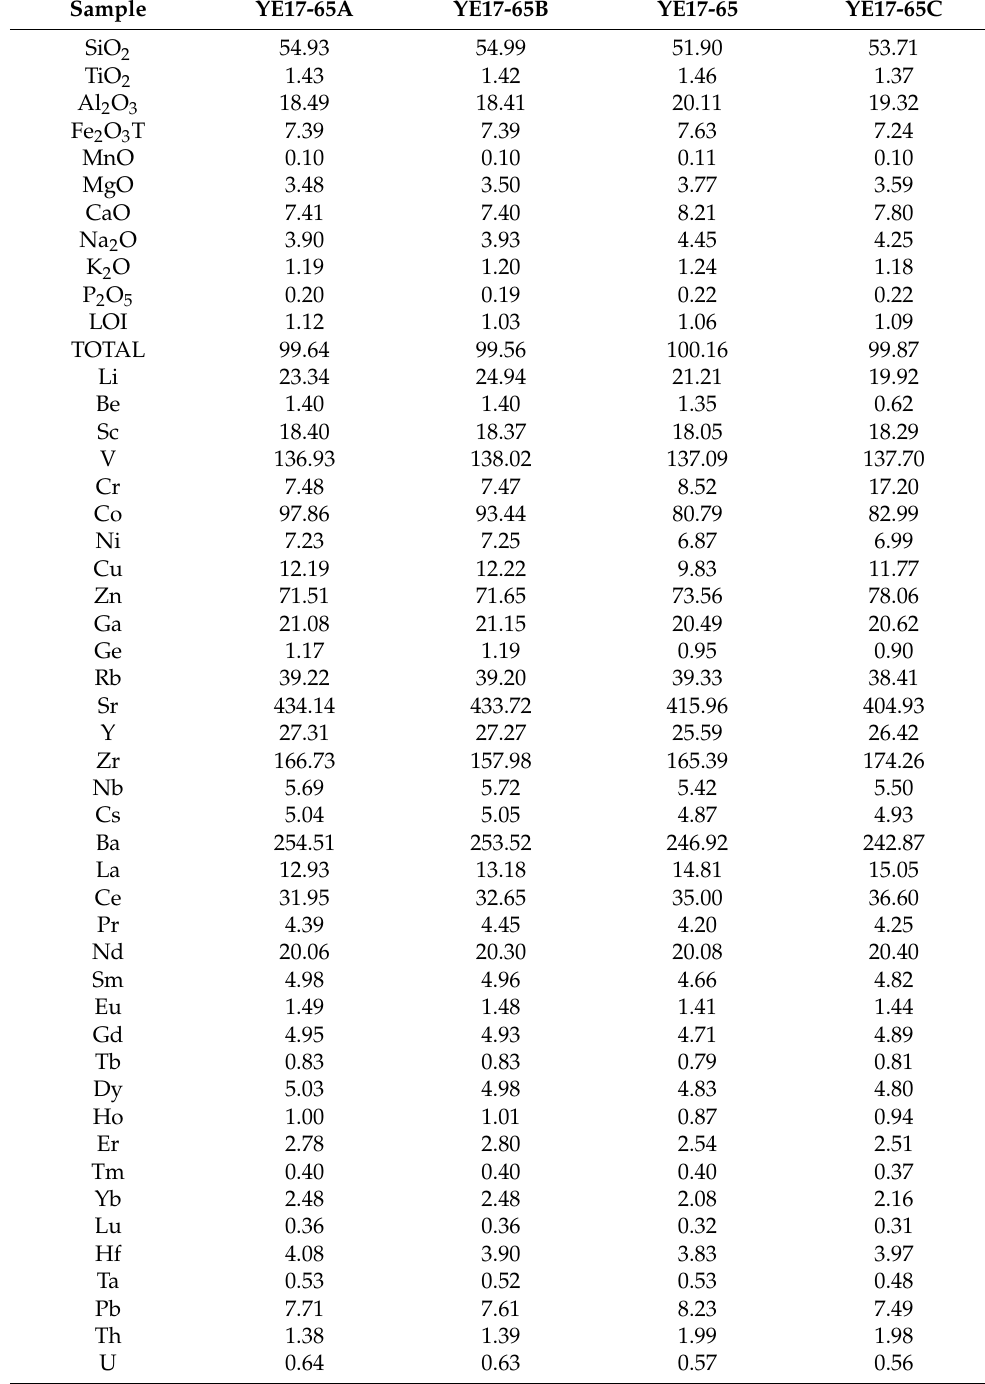
Table A4. Major (wt. %) and trace element compositions (in ppm) for the hornblende gabbro of the Baogeqi gabbro